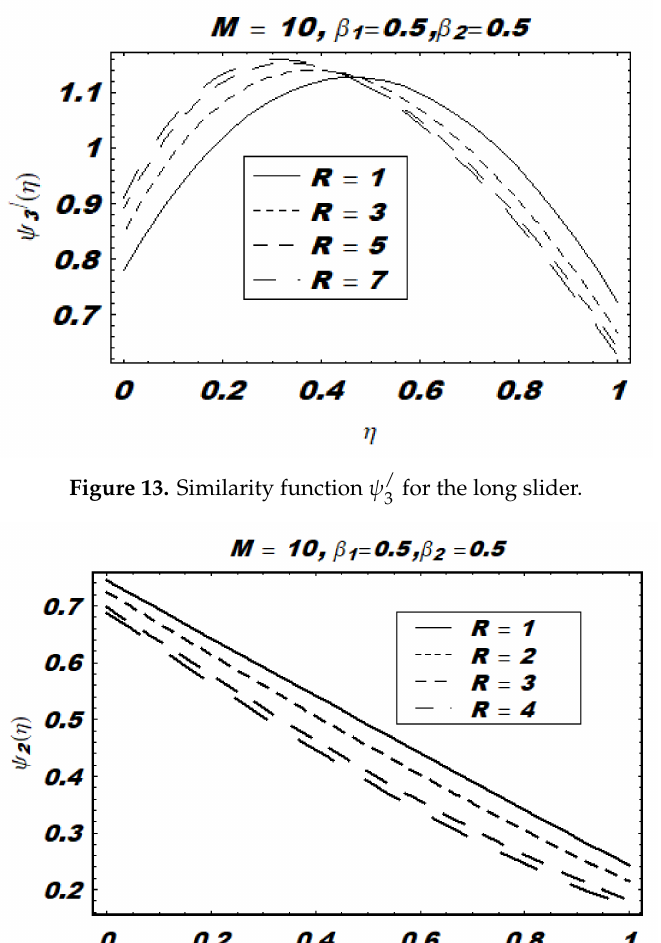
Figure 14. Similarity function ψ 2 for the long slider.